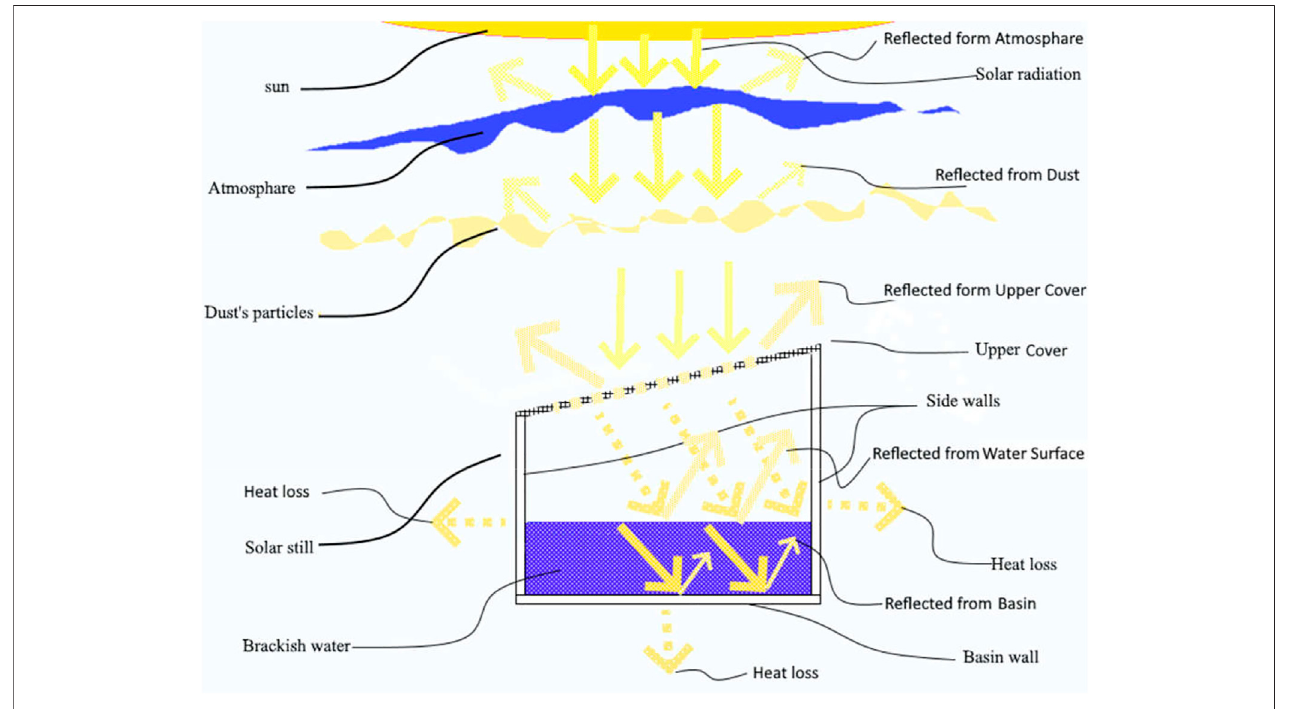
FIGURE 2 | Schematic representation of energy cascade for conventional solar